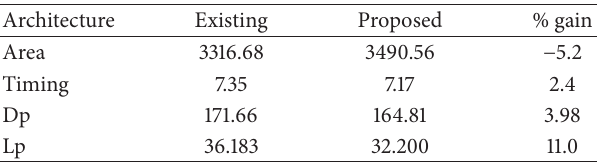
Table 2: Results of existing and proposed digital filter architectures of QRS